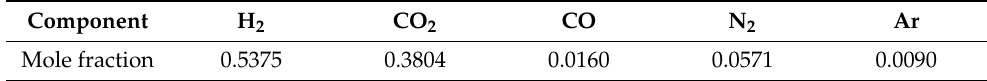
Table 1. Normalised synthesis gas key component fractions after desulphurisation and dehydration. Component